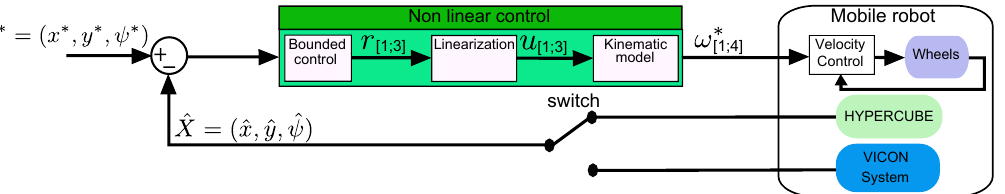
Figure 9. Block diagram of the robot autopilot. The position and heading are controlled in closed-loop. The mobile robot is equipped with HyperCube